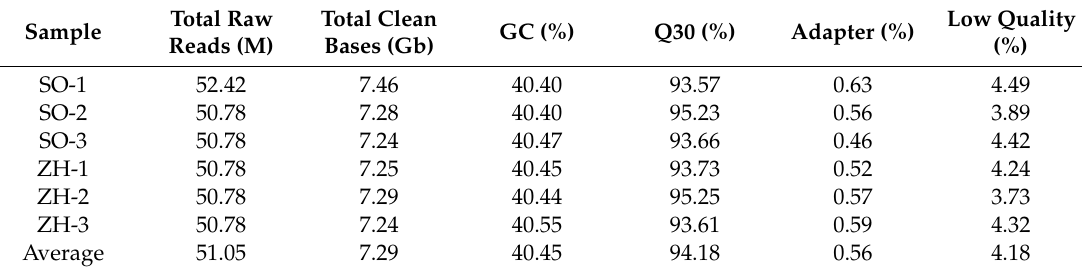
Table 1. Output statistics of RNA-seq of ‘SO’ and ‘ZH’.